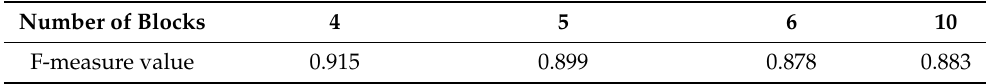
Table 6. F-measure value for different number of cross-validation